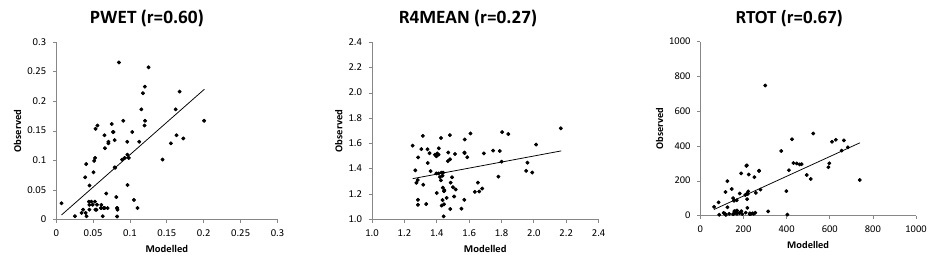
Fig. 8. Model validation using Network B parameters estimated from ELEV and TRMM(V7). Note that the observed RTOT outlier (748mm) was for an un-named high altitude AREA station. Rainfall recorded at this site was anomalously high when compared with the nearest stations at Absiah (140mm) and Al-Kalabah